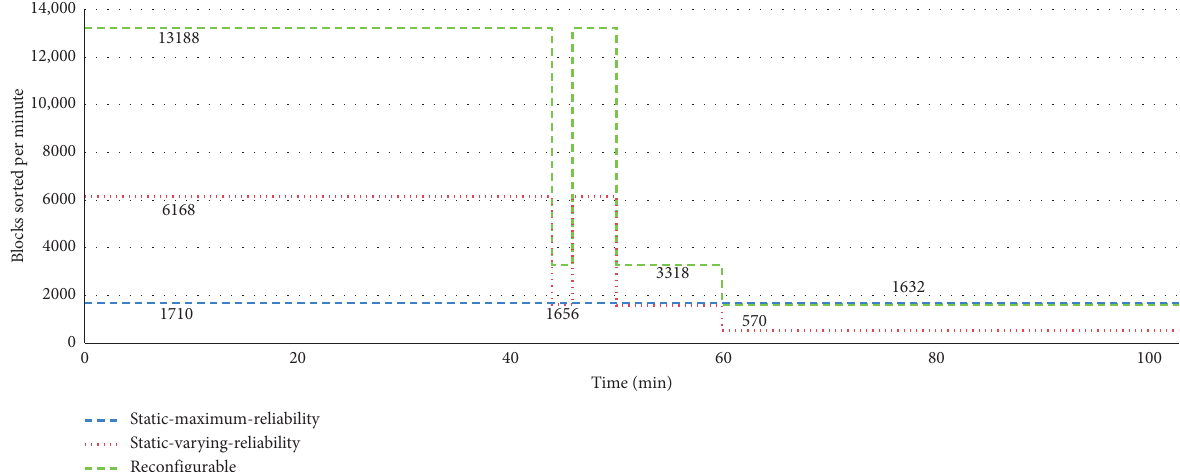
Figure 10: Performance results for static-maximum-reliability, static-varying-reliability, and reconfigurable configurations of data